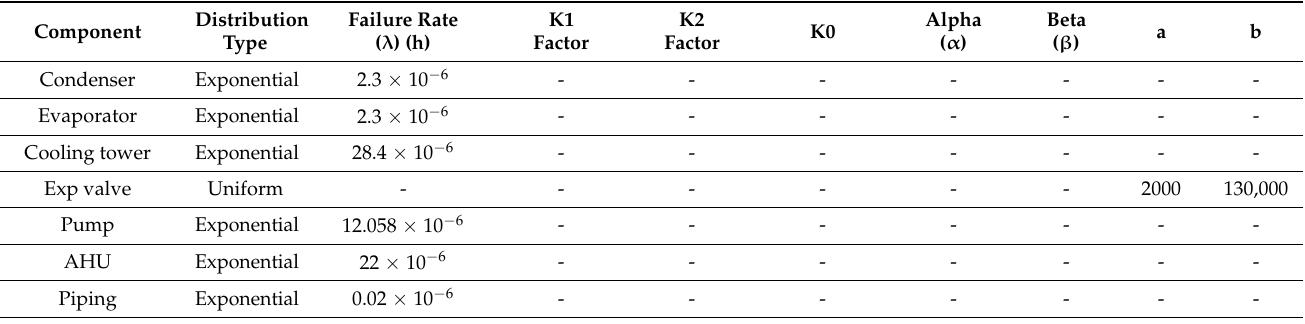
Table 1. List of distribution parameters for each